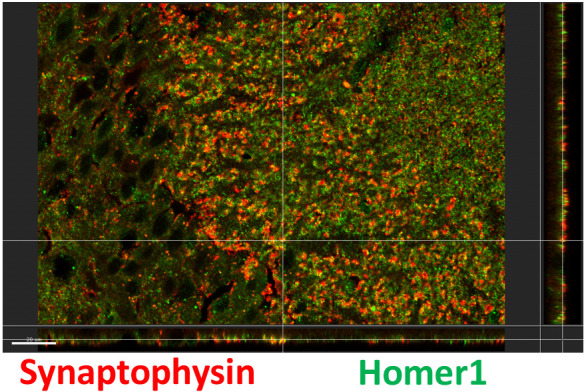
Confirmation of antibody colocalization with orthogonal view.Representative image from Imaris showing colocalization of synaptophysin and homer1 with the orthogonal views (YZ on the right and XZ on the bottom).